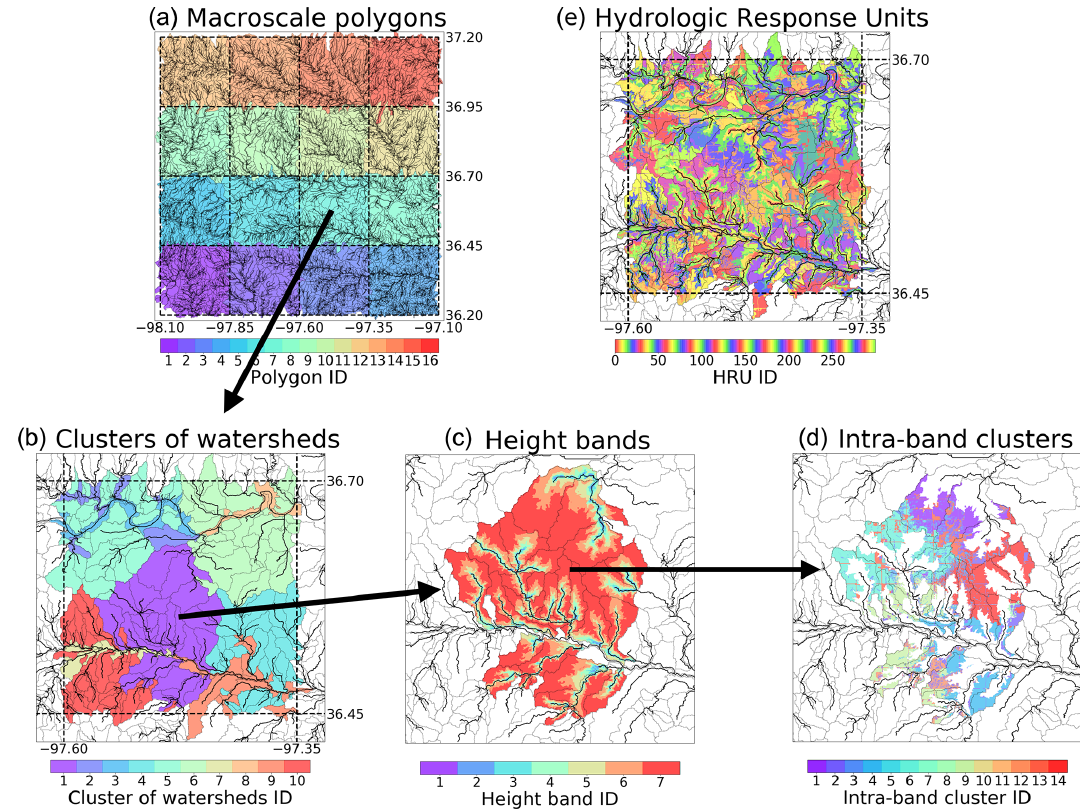
Figure 2. (a) The domain is split into 16 macroscale polygons, where each color identifies a polygon. (b) Each macroscale polygon is partitioned into 10 clusters of watersheds via K -means clustering. (c) The HAND data are used to discretize each cluster of watersheds from channel to ridge; this discretization allows us to assemble the channel and non-channel height bands. Finally, each of the height bands is split into intra-band clusters (d) . The (c) and (d) methods are applied to all clusters of watersheds in (b) to assemble the final HRU map (e)